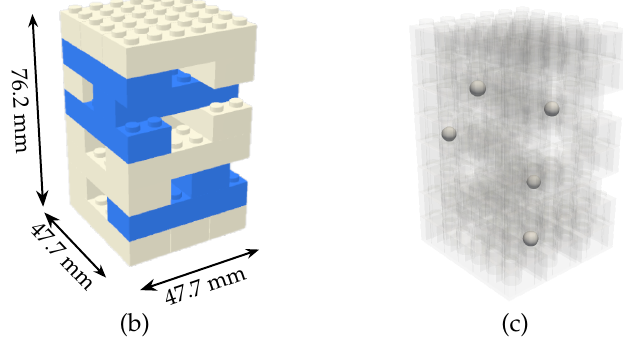
Figure 1. The 3D 2 YMOX system ( a ), LEGO calibration phantom with embedded metal markers in the blue bricks ( b ) and its transparent view ( c